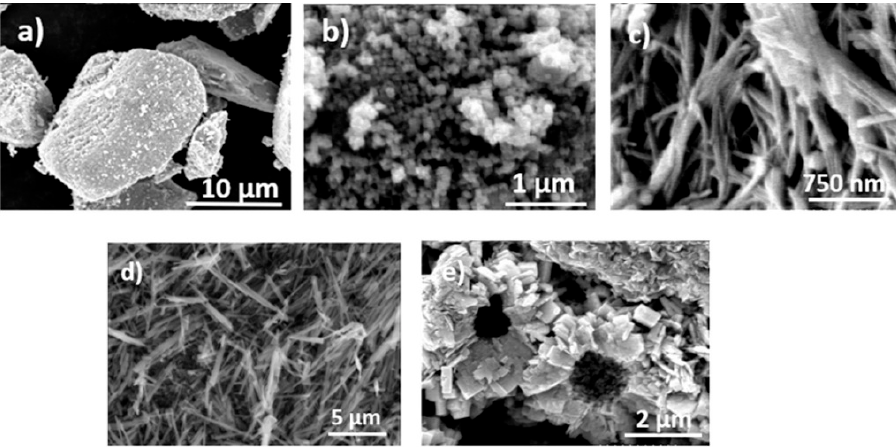
Figure 1. FESEM images of ( a ) WO 3 micron, ( b ) WO 3 nanopowder, ( c ) WO 3 wires, ( d ) WO 3 rods, and ( e ) WO 3 flowers.